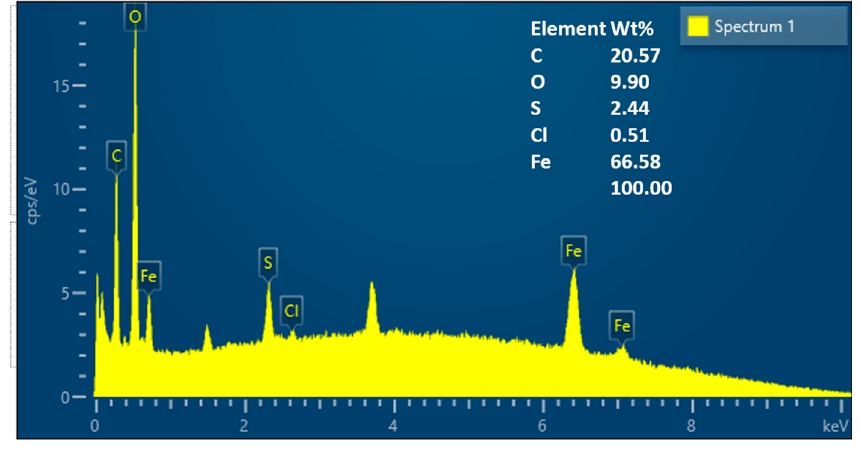
Figure 4. EDX analysis for GA-MNPs.